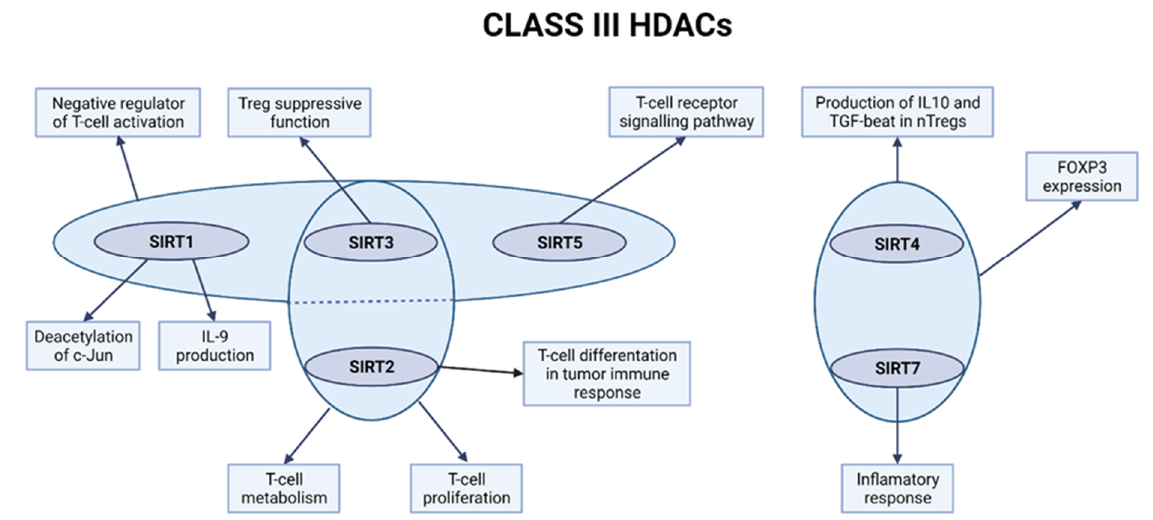
Figure 3. The role of class III HDACs in T-cells. Created with BioRender.